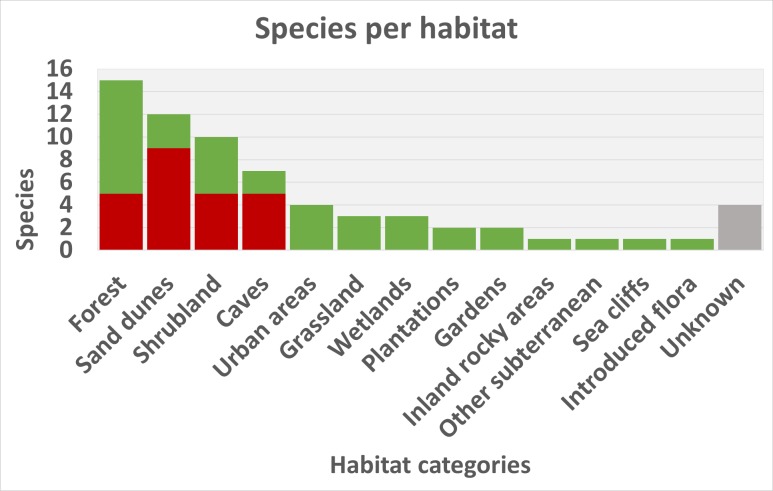
Habitat categories amongst all 42 species assessed. Species exclusive to each habitat in red.